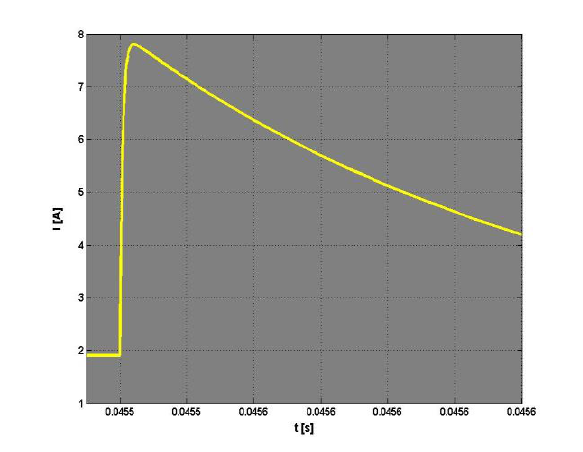
Fig. 3. The course of the current signal on the receiver.